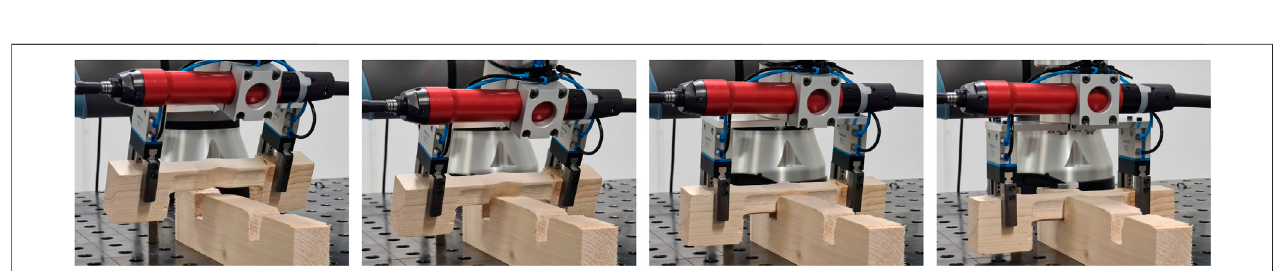
FIGURE 8 | Executionofthedemonstratedtrajectoryin4phases(approach (left) ,alignment (middle-left) ,interlocking (middle-right) and fi nalcon fi guration (right) ).